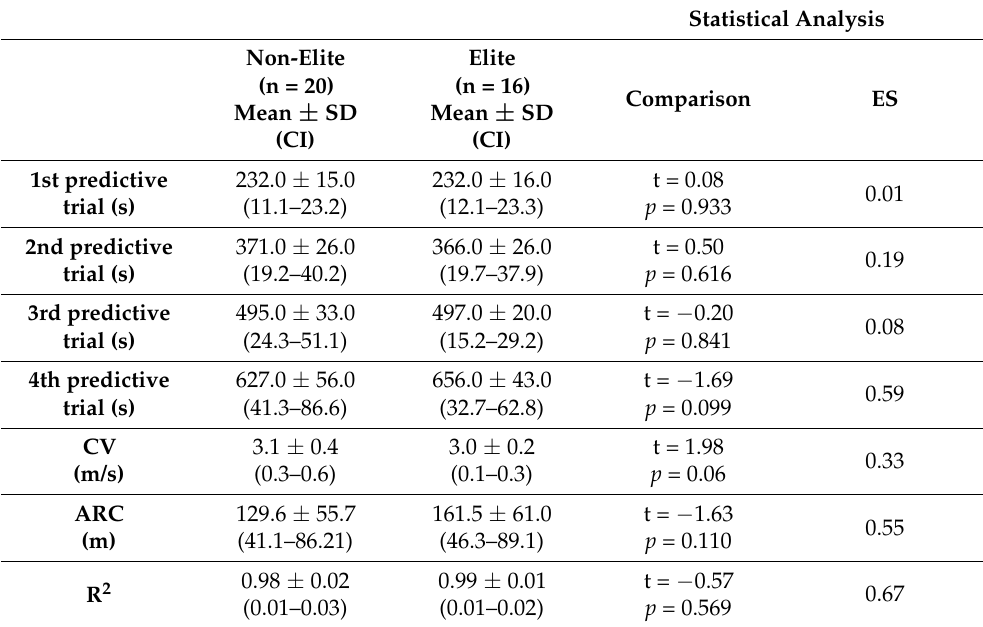
Table 2. Predictive trials and aerobic and anaerobic capacities of both teams from the application of the critical velocity